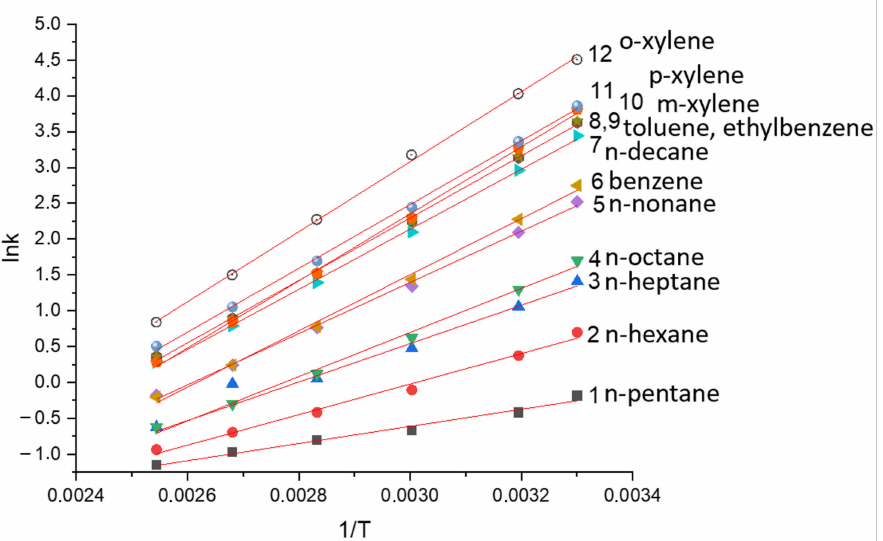
Figure 4. Linear dependence of lnk on inverse column temperature 1/T c for solutes of the test mixture in the MP stationary phase. The designation of solutes is shown in Figure